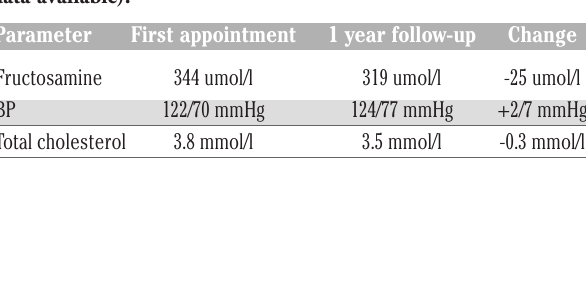
Table 4. Change in metabolic control in Joint Clinic (follow-up data available).